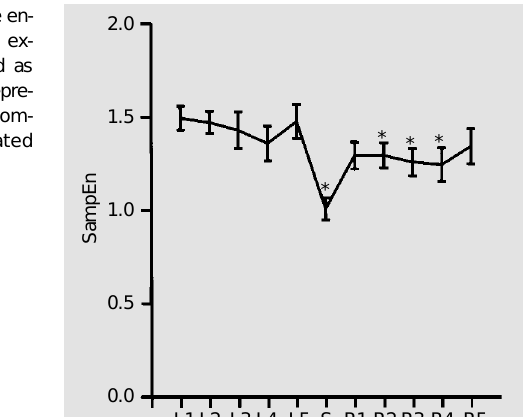
means and the error bars